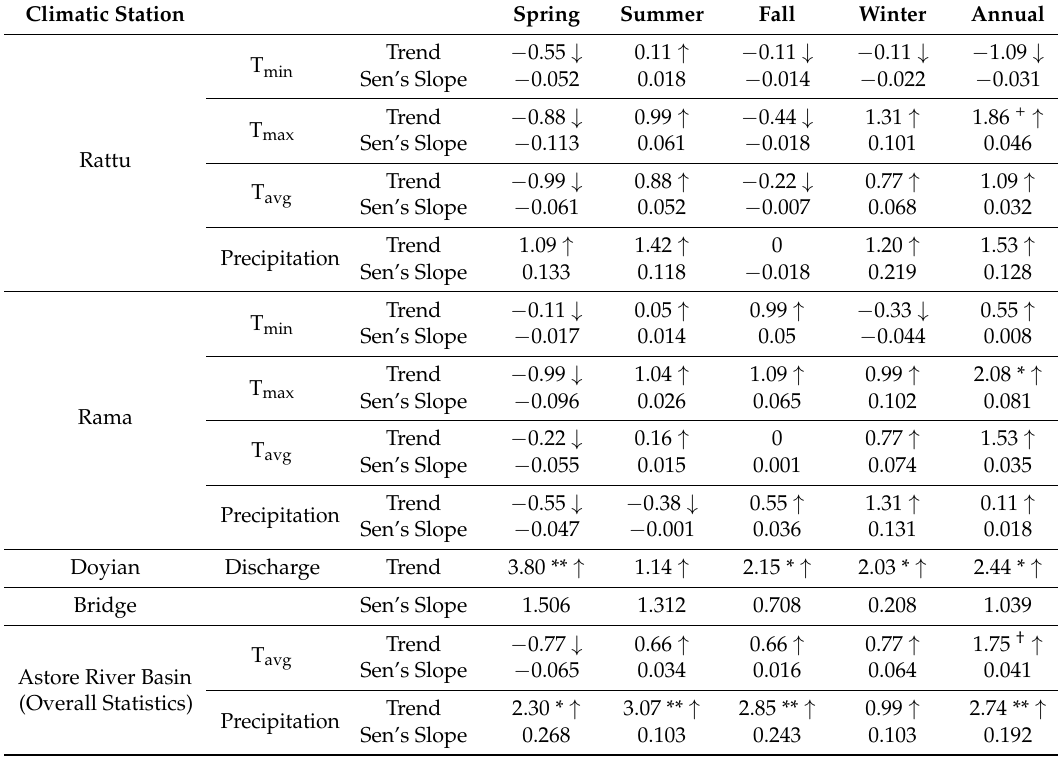
Table 3. Shows the Mann-Kendall trend and Sen’s slope estimator on an annual and seasonal basis in Astore Basin. Sen’s slope temperature, precipitation and discharge are increasing or decreasing in